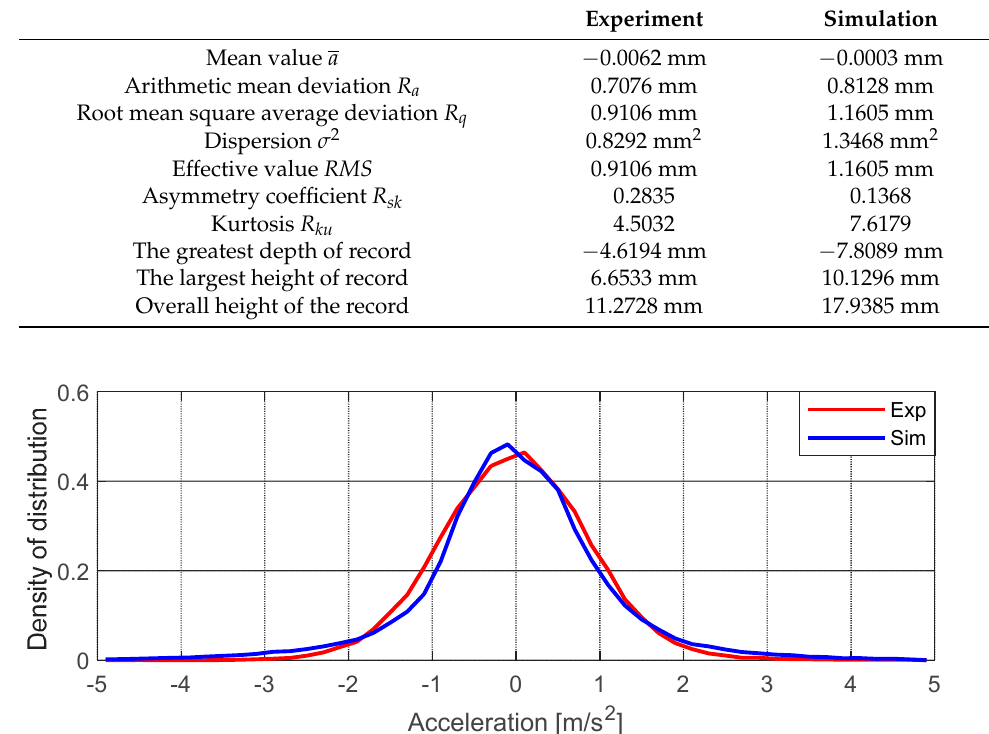
Table 4. Statistical characteristics of acceleration on right rear axle.